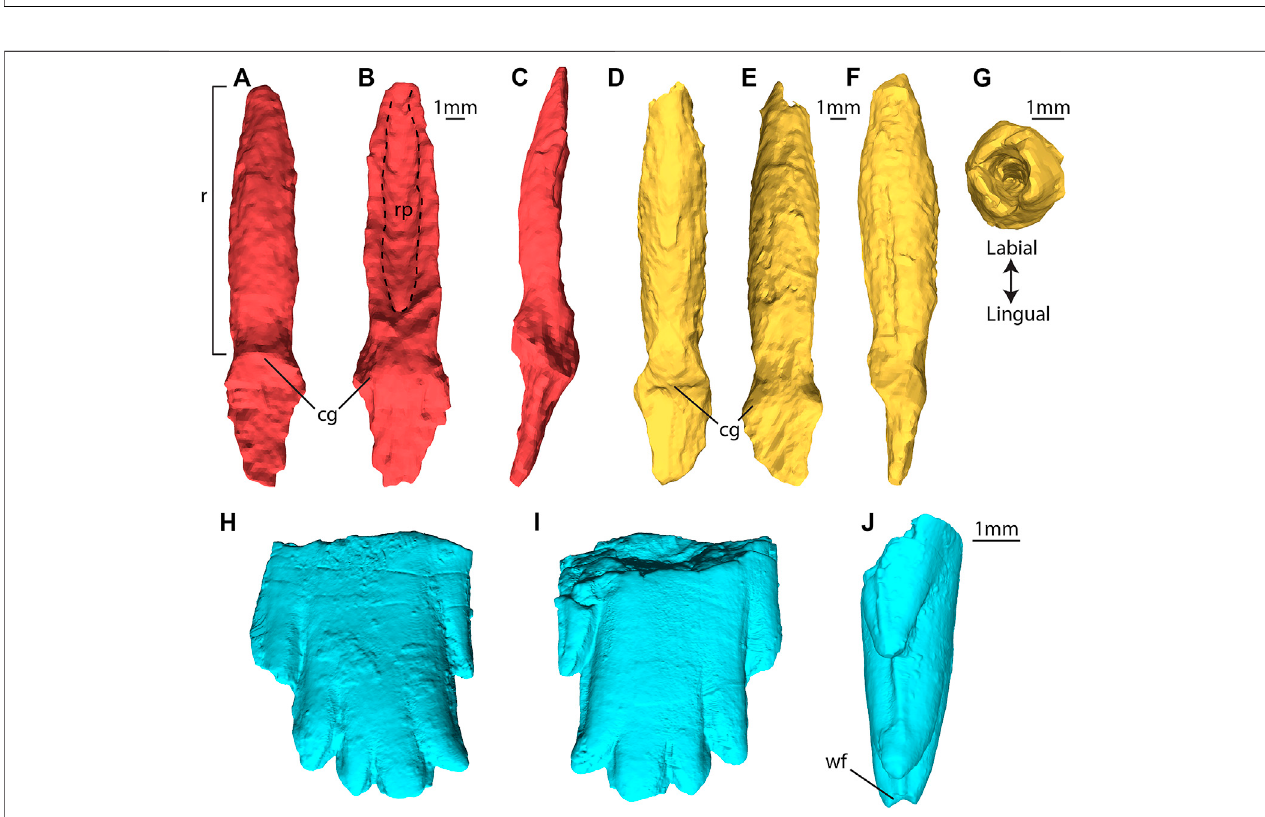
FIGURE 7 | Three-dimensional models of select SAMA P40536 maxillary teeth. (A – C) Ex situ maxillary tooth in (A) lingual, (B) labial, and (C) distal views. (D – G) Ex situ maxillary tooth in (D) lingual, (E) labial, (F) mesial, and (G) basal views. (H – J) In situ (MicroCT) posterior maxillary tooth in (H) lingual, (I) labial, and (J) apical-mesial views. (A – G) Preserved within the block, extracted virtually. (H – J) Was manually prepared and subsequently, micro-CT scanned. Abbreviations: cg, cingula; r, root; rp, resorption pit (outlined in a dashed line in B); wf, wear facet. Tooth colors correspond to those in Table 1 and Supplementary Material S1 ( ex situ ) and Supplementary Material S2 ( in situ